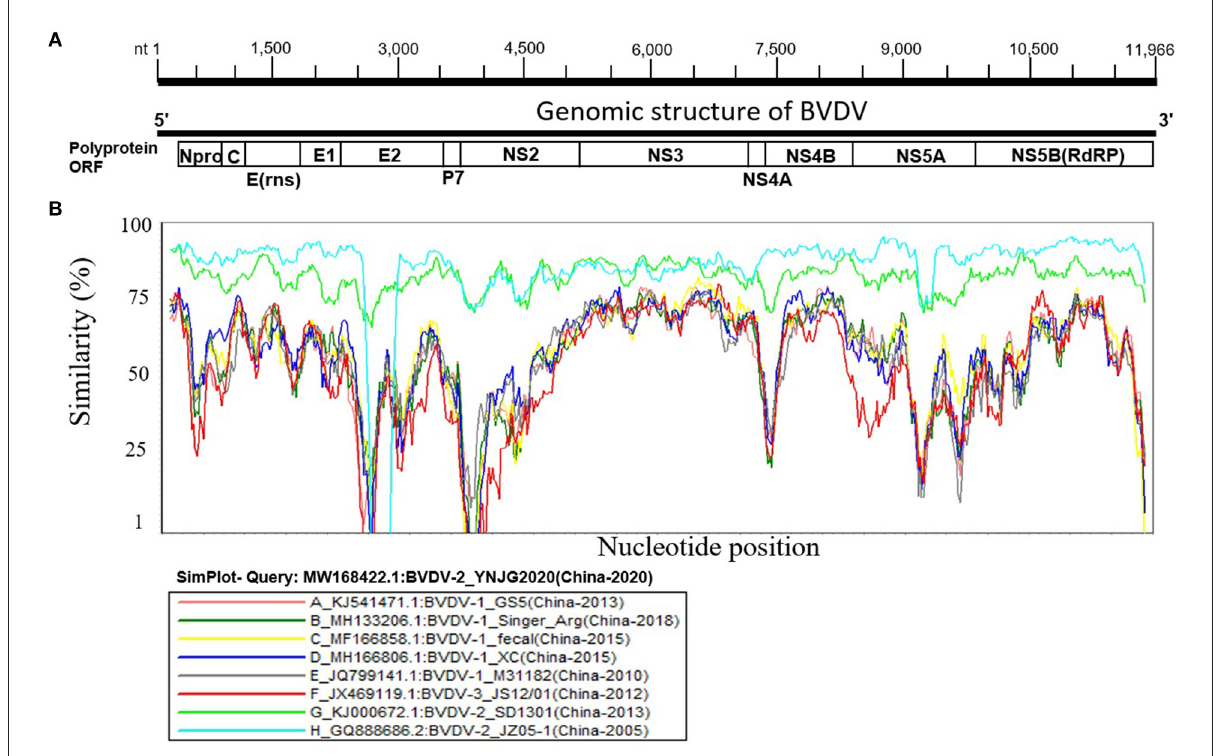
FIGURE2 Similarity map of the full-length genome sequence of representative BVDVs isolated in China. (A) Schematic diagram of the complete BVDV genome structure. From the 5 ′ end to the 3 ′ end is replicase polyprotein ORF encoding proteins Npro, C, Erns, E1, E2, P7, NS2, NS3, NS4A, NS4B, NS5A, and NS5B. (B) SimPlot similarity analysis results using BVDV-2 isolate YNJG2020 (GenBank ID: MW168422.1) as the query sequence to compare with the eight other representative strains isolated in China.